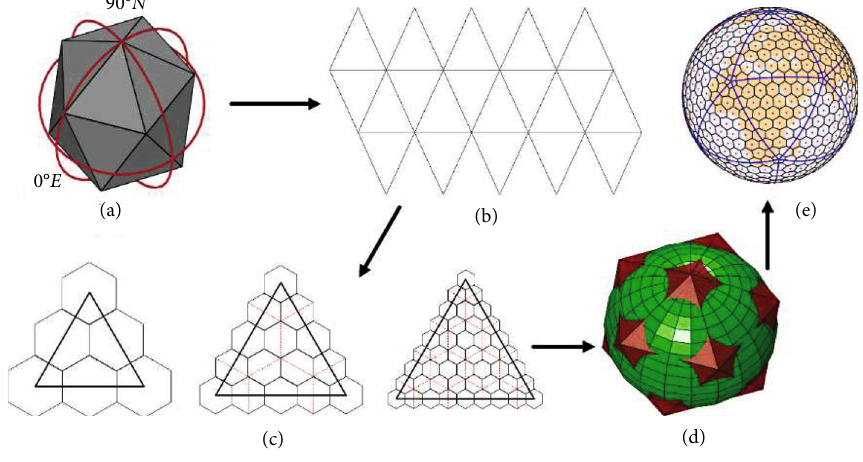
Figure 2: Hexagonal grid generation process. Table 1: Parameter statistics of the icosahedral Snyder equal area aperture 4 hexagon (ISEA4H) grid (with a spherical radius of R = 6378 : 136 km